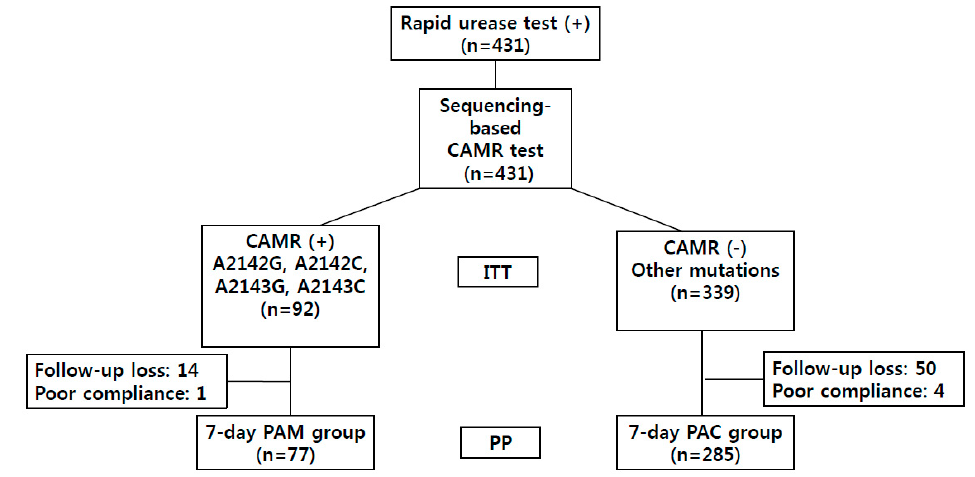
Figure 1. Flow chart of the study. CAMR, clarithromycin resistance; PAM, proton pump inhibitor, amoxicillin, and metronidazole; PAC, proton pump inhibitor, amoxicillin, and clarithromycin; PP, per-protocol analysis; ITT, intention-to-treat